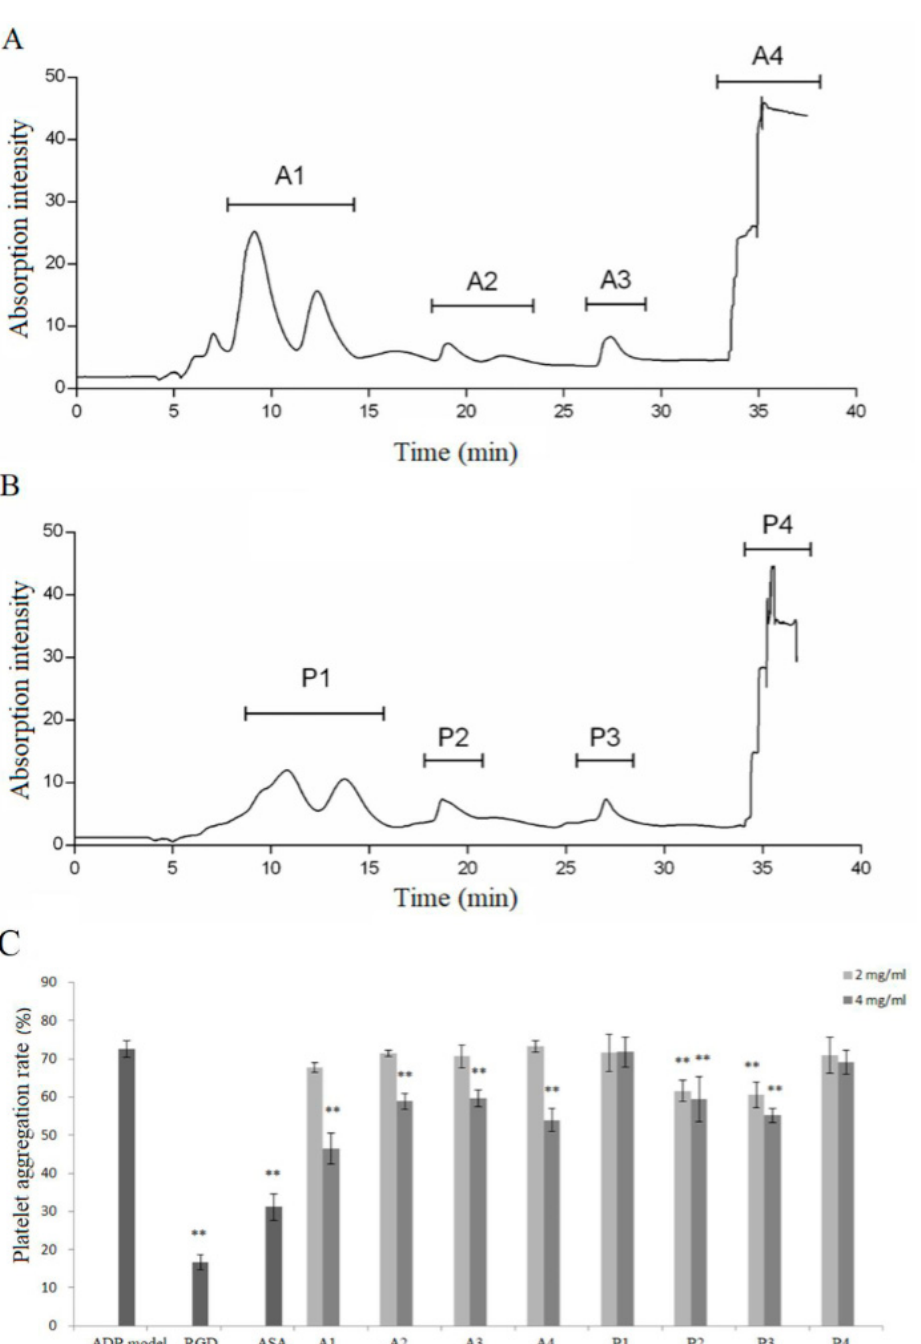
Figure 2. Separation scheme of antiplatelet peptides obtained from absorbate of skin collagen hydrolysates from Hypophthalmichthys Molitrix and their inhibition rate of ADP-induced platelet aggregation. ( A , B ) Reverse-phase chromatography on a C18 column. ( A ) Absorbates of Alcalase hydrolysates, AHA. ( B ) Absorbates of Protamex ® hydrolysates, PHA. Each sample was separated into 4 fractions, respectively (A1–A4; P1–P4). ( C ) Effect of each fraction on inhibiting ADP-induced platelet aggregation in vitro. Mean ± SD, n = 5, * p < 0.05, ** p < 0.01, ANOVA, compared with the model group. The side effects (such as bleeding risk and immune response) of OGSA were further evaluated in vivo [37]. The prothrombin time (PT), activated partial thromboplastin time (APTT), and thrombin time (TT) in rats after oral administration of OGSA were determined to assess its potential bleeding risk. The results showed that OGSA (200 and 300 µ